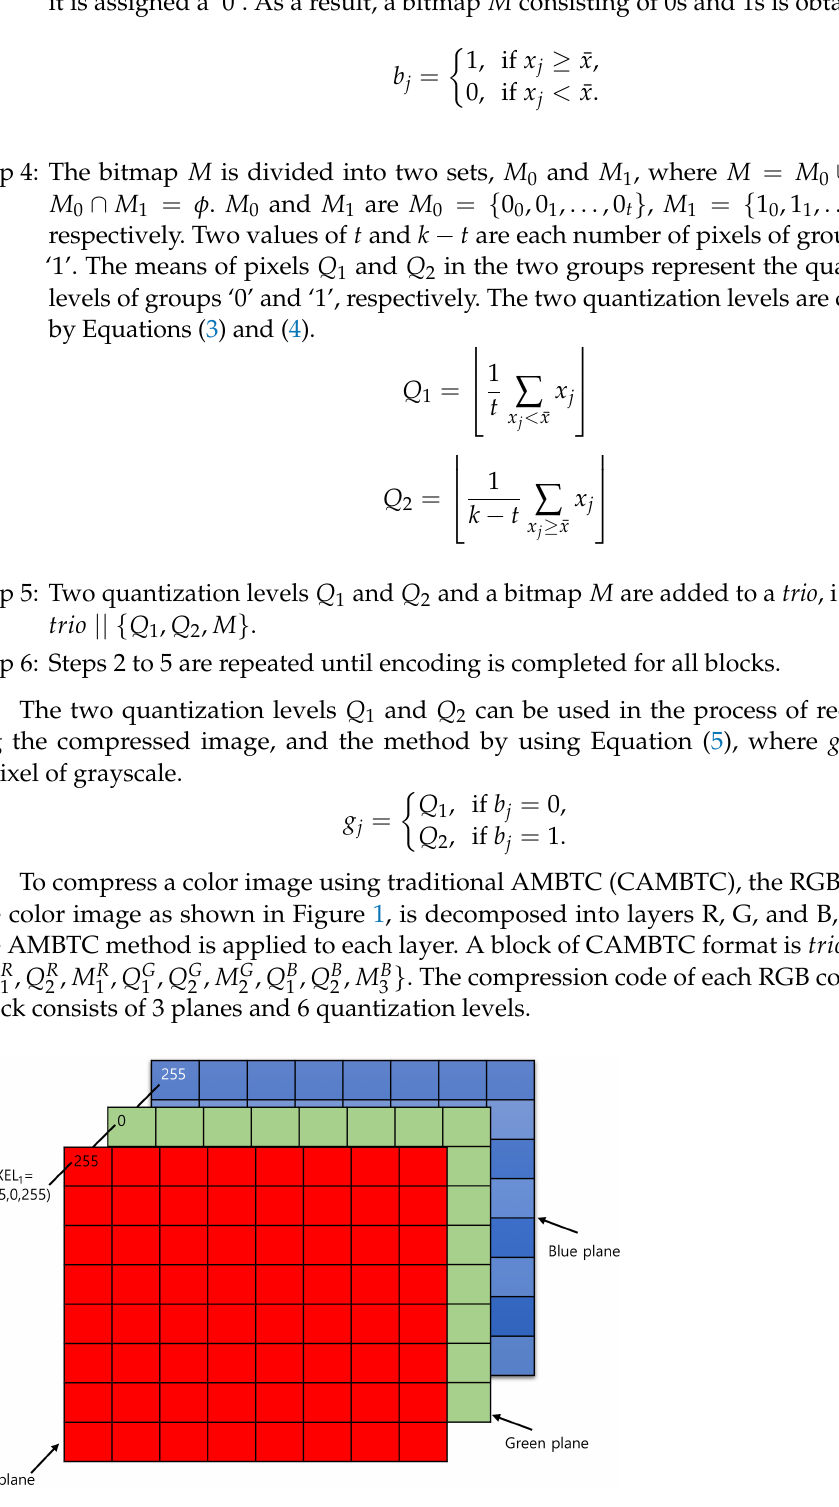
Figure 1. RGB image consisting of three